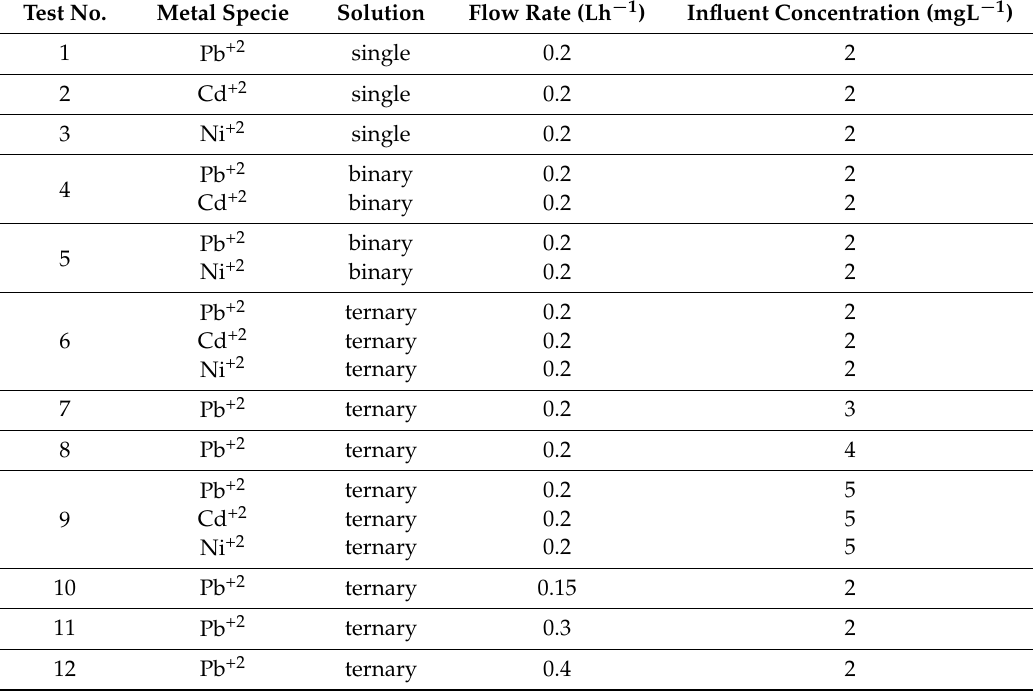
Table 1. Summary of the column tests carried out on recycled waste porous glass (RWPG) sorbent (10